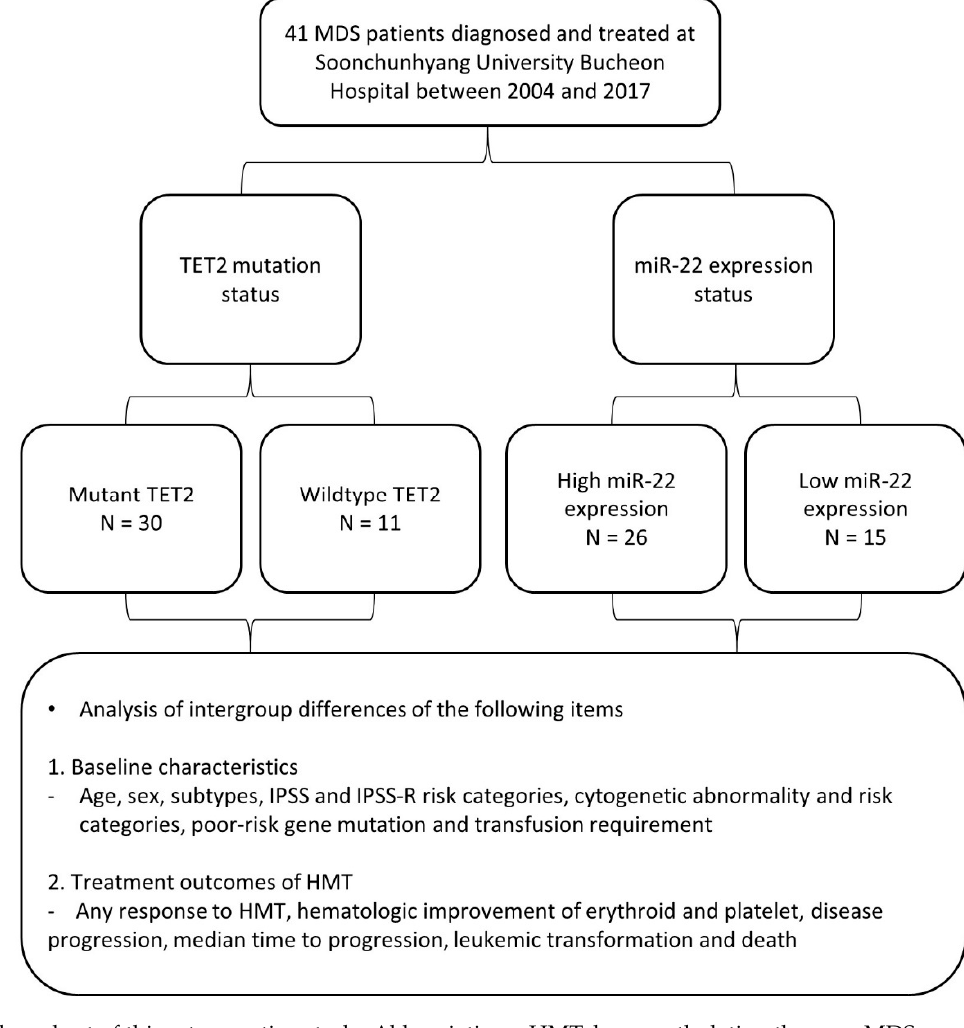
Figure 1. Flow chart of this retrospective study. Abbreviations: HMT, hypomethylating therapy; MDS, myelodysplastic syndrome; TET2, Tet methylcytosine dioxygenase 2; IPSS, International Prognostic Scoring System; IPSS-R, Revised International Prognostic Scoring System.